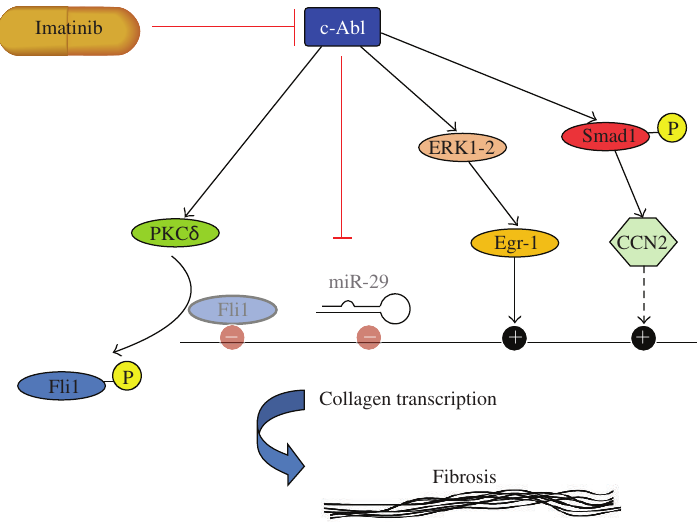
FIGURE 3: Antifibrotic effect of TKI: the original target of Imatinib, c-Abl, is involved in several molecular pathways leading to fibrogenesis. Interference of TKI with other molecules involved in fibrotic pathways (PDGFR and Src kinases) are not illustrated due to required